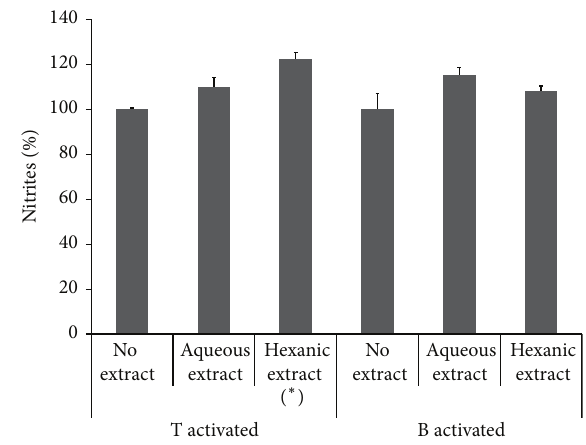
Figure 1: Nitrite% in T- and B-activated cultures treated for2 h with 200 𝜇 g/mL of L. grisebachii extracts. Results were averaged from three separate experiments ( ∗ 𝑃 < 0.01